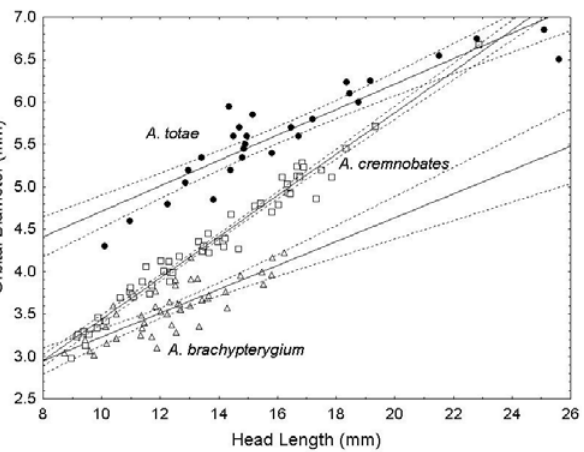
Fig. 4 . Orbital diameter as function of Head Length in Astyanax totae , A. cremnobates and A. brachypterygium. Note that the confidence intervals (95%) do not overlap in A. totae and A. brachypterygium , indicating significant difference. In head lengths of about 8 to 21 mm the 95% confidence intervals do not overlap in A. totae and A. cremnobates , indicating a sig- nificant difference in these size